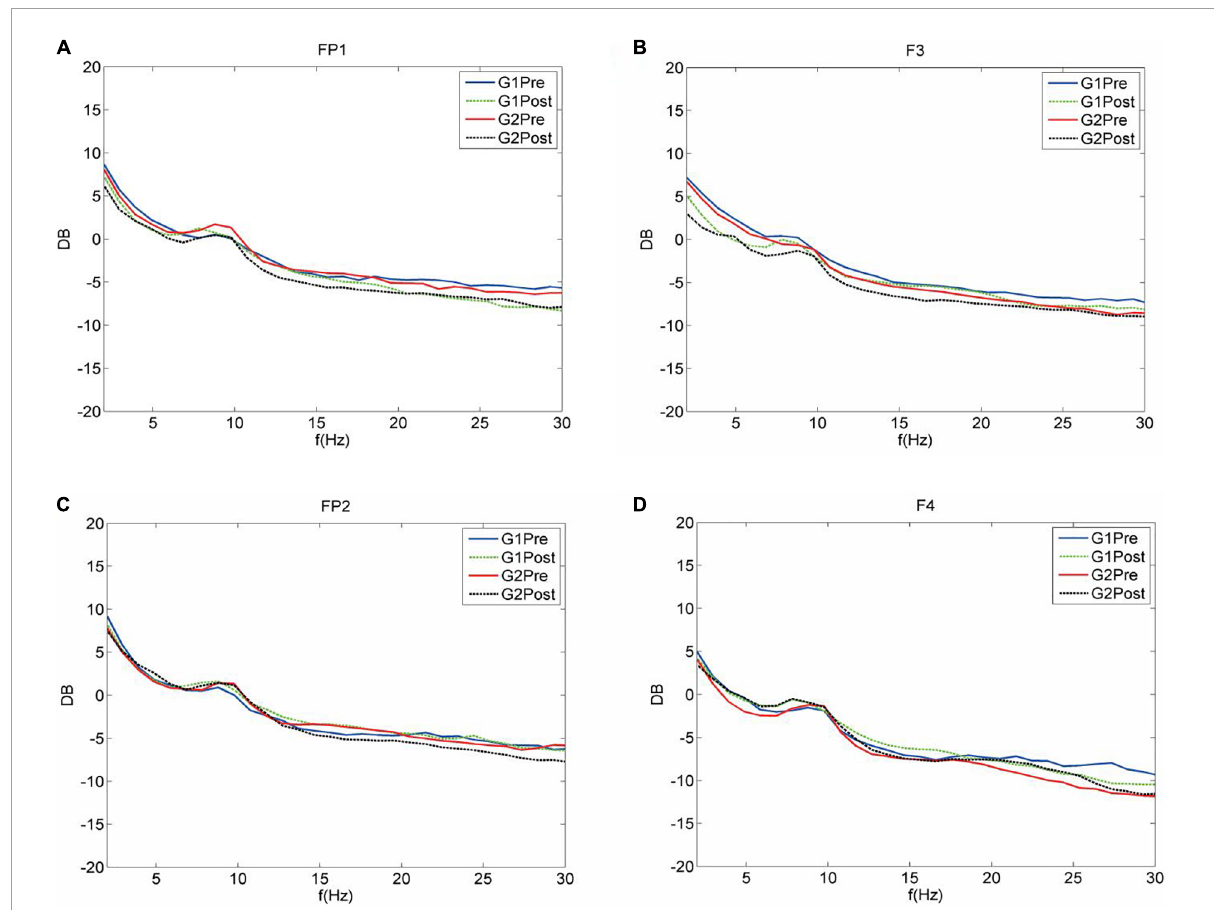
FIGURE10 Average spectrum curves of the full leads. The average spectrum curves of both groups were significant before and after treatment (Fp1.Fp2.F3.F4). Delta band (1–4 Hz); theta band (4–8 Hz); alpha band (8–13 Hz); and beta band (13–30 Hz). (A) FP1 G1 of the control group before treatment. The values for the delta and theta band power increased, whereas, those for the alpha band power decreased. However, the alpha band power increased after treatment. G2 before treatment of the treatment group. Increasing trend in the powers of four frequency bands. The powers of the four frequency bands decreased after treatment. (B) F3 left frontal lobe G1 of the control group before treatment, Delta, theta, alpha, and beta bands showing an increasing trend in power. After treatment, the delta and beta bands showed a decay of power, whereas the theta band power increased. G2 of the treatment group. The powers of four frequency bands showing an increasing trend. The powers of the four frequency bands decreased after the treatment. (C) FP2 G1 of the control group before the treatment. The alpha band power showed an increasing trend, whereas the powers of the delta, theta, and beta bands showed a decreasing trend. After treatment, the alpha and beta band powers increased. G2 of the Qigong group showed a delta power coast down and increases in the delta, alpha, and beta powers. After treatment, the delta power increased, whereas the theta and beta powers showed a coast down. (D) F4 G1 of the control group before the treatment showed decreases in the delta, theta, alpha, and beta band powers. After treatment, the delta and beta bands showed a decay of power, whereas the alpha band power increased. G2 of the Qigong group showed decreases in the delta, theta, and beta band powers. After treatment, the delta, theta, and beta band powers